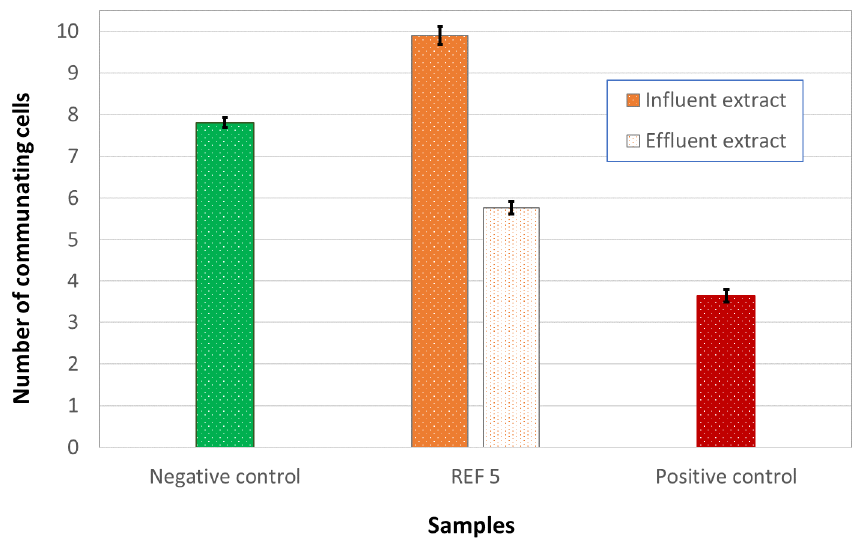
Figure 4. Gap junction Intercellular communication was assessed in IAR203 hepatic cells exposed to influent and effluent wastewaters. The error bars show the standard error of mean.